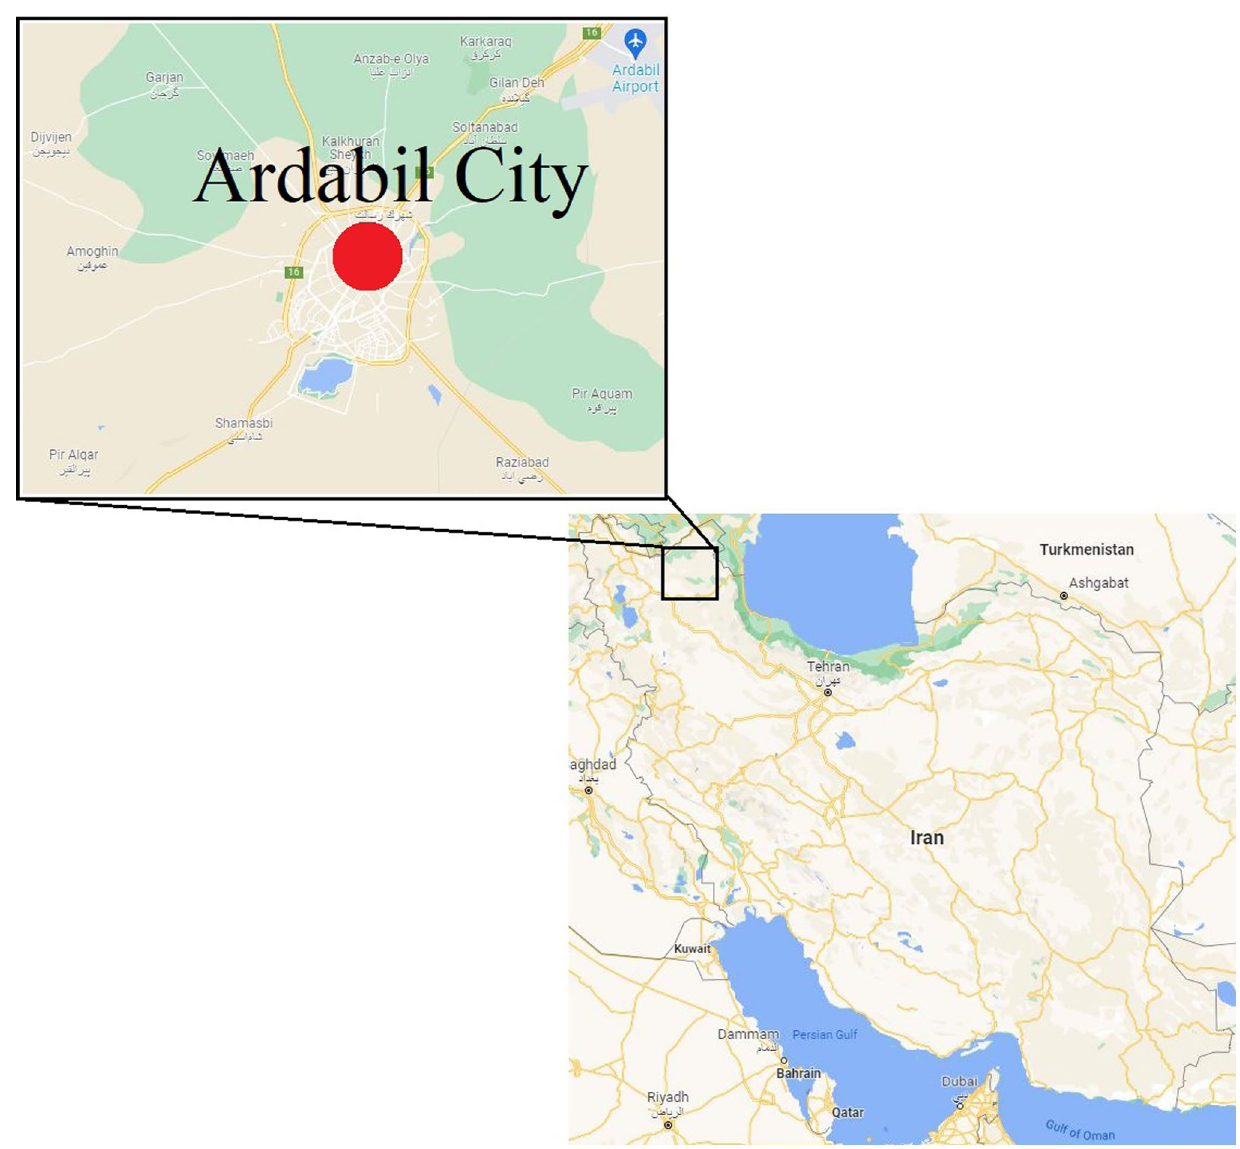
Fig. 1 The location of Ardabil city, Iran, as the study area in this